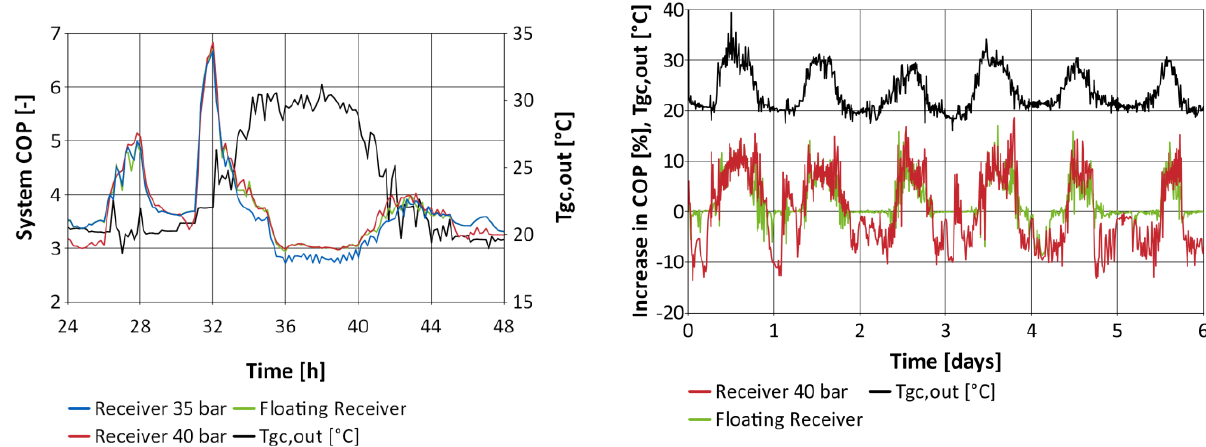
Figure 12. Analysis of strategies for receiver pressure control in integrated CO 2 refrigeration systems with HP ejector. ( Left ) Evolution of the system COP during a day with the different setpoints. ( Right ) Increase in COP during the reference week on the basis of the HP ejector system with 35 bar setting.